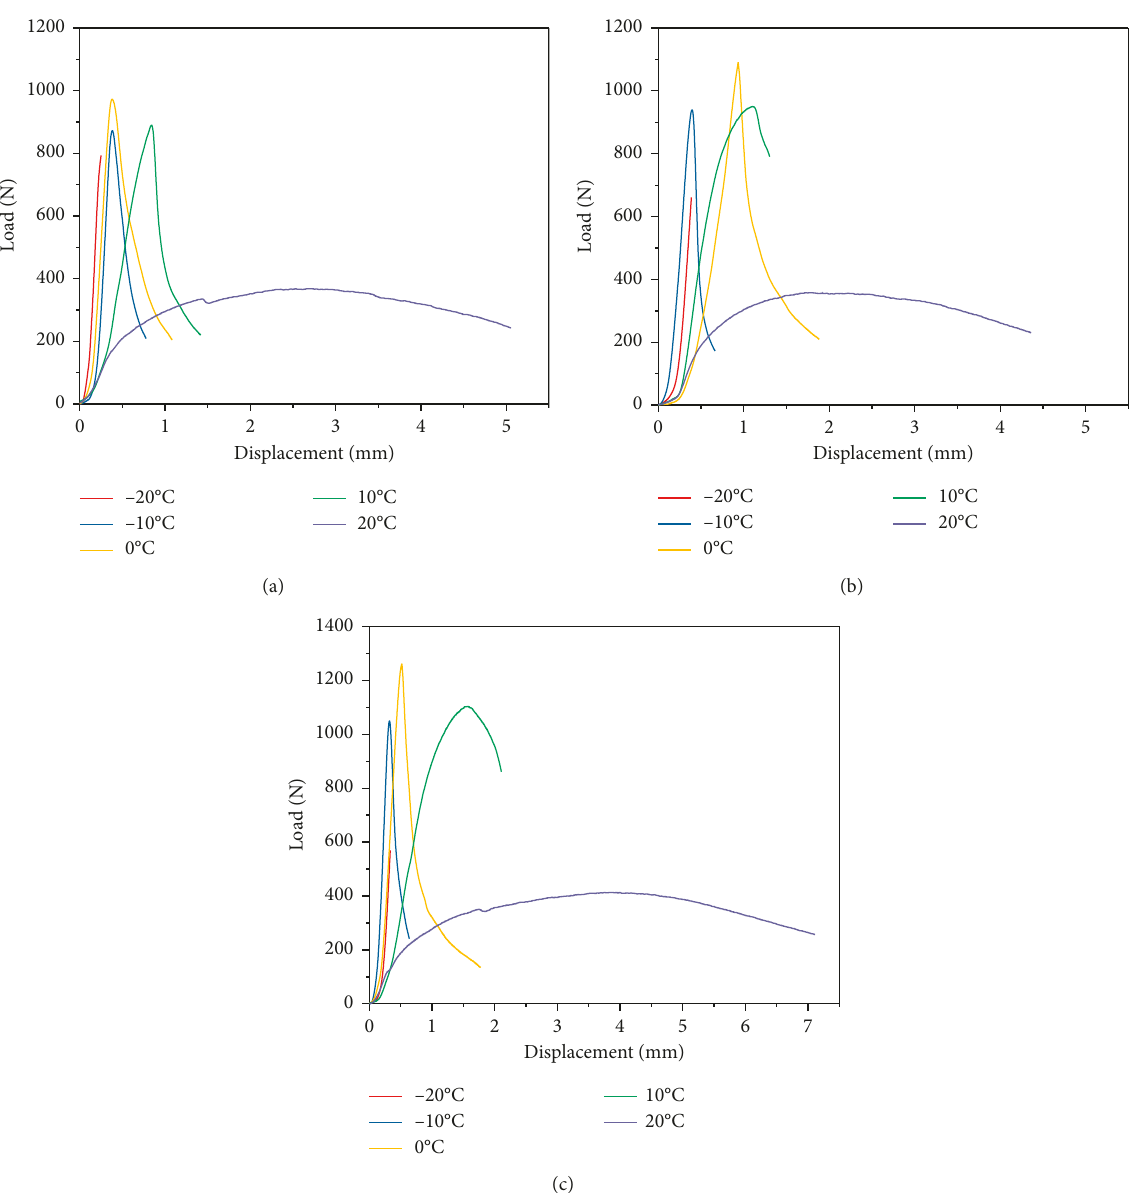
Figure 9: Load-displacement curves at different temperatures: (a) AC-13, (b) AC-16, and (c)